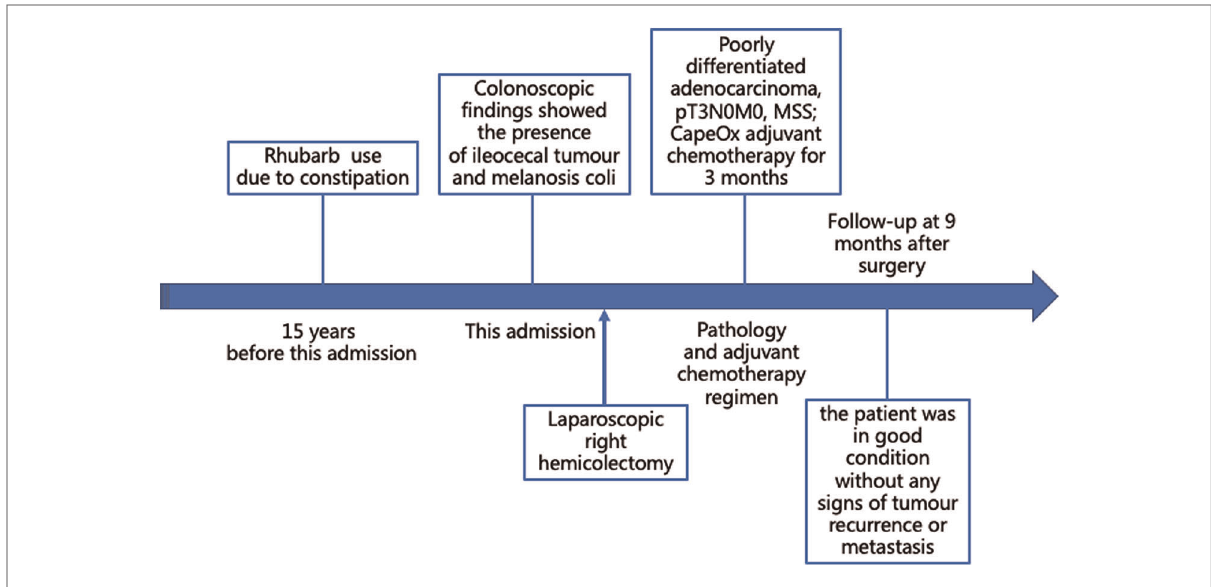
FIGURE 4 Patient ’ s timeline of anthraquinone laxative use, colonoscopy fi ndings, and treatment. MSS, microsatellite